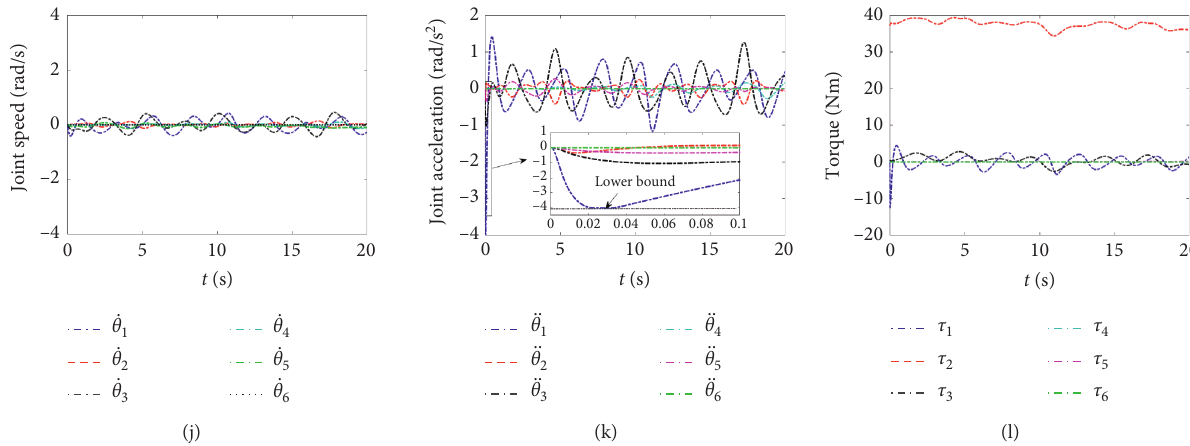
Figure 1: Comparison between the velocity level scheme equation (11) (a–f) and the acceleration scheme equation (10) (g–l) when the manipulator is expected to follow a butterfly path. From left to right are 3D tracking results, planer tracking results, tracking error profiles, joint speed profiles, joint acceleration profiles, and joint torque profiles.